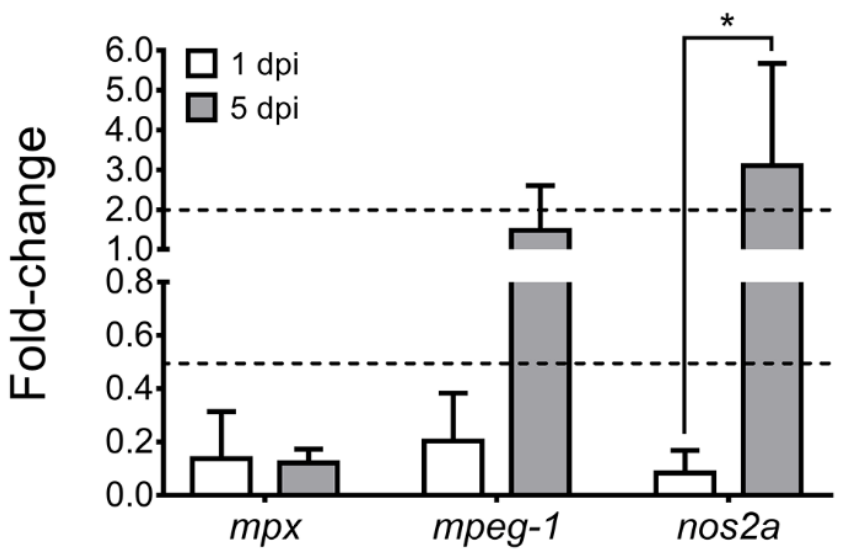
Figure 3. Identification of mpx -, mpeg-1 - and nos2a -expressing cells in zebrafish kidney primary cell cultures. Relative gene expression was quantified after 1- and 5-dpi with P. salmonis or culture medium as control. Gene expression is expressed as relative to the housekeeping genes. Dotted lines indicate non-significant changes in expression levels (between 0.5- and 2-fold). Asterisks show significant differences compared to control samples (two-way ANOVA with Fisher’s post-test for multiple comparisons, * p < 0.05).